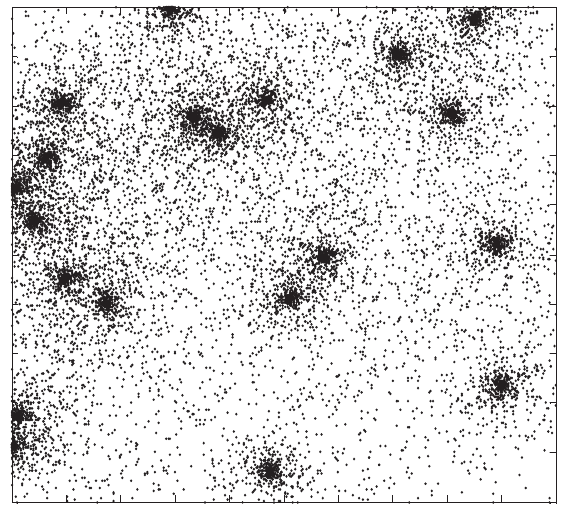
Figure 1. Example of a heterogeneous topology network. The parameter of the network is n = 10,000, v = 0.3 and δ =